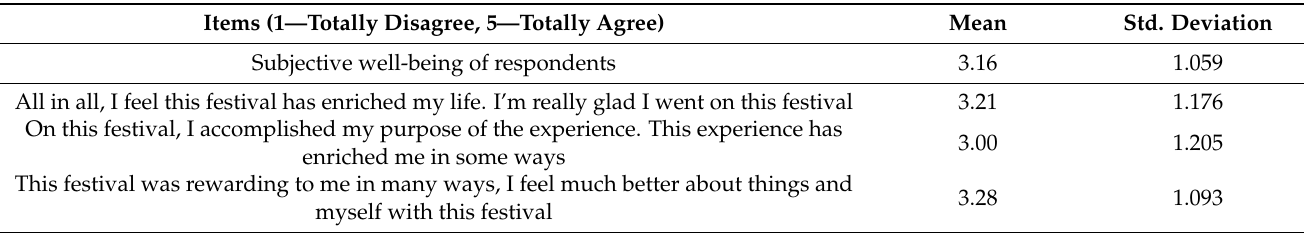
Table 4. Means and standard deviations of the items referring to subjective well-being of respondents. Items (1—Totally Disagree, 5—Totally